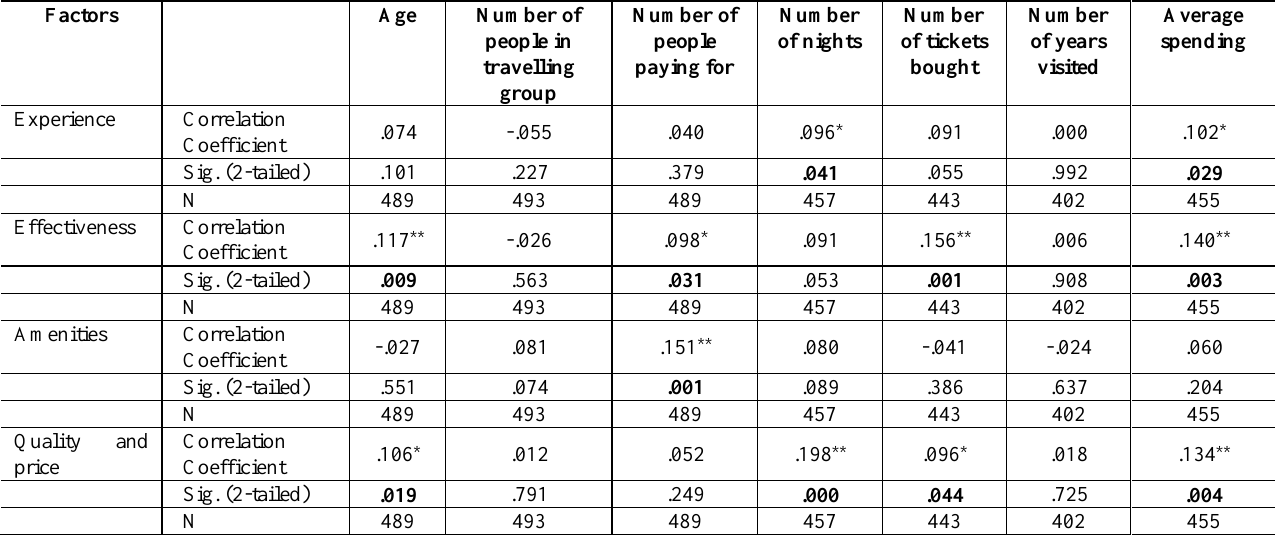
Table 4: Factors influencing value for money perceptions